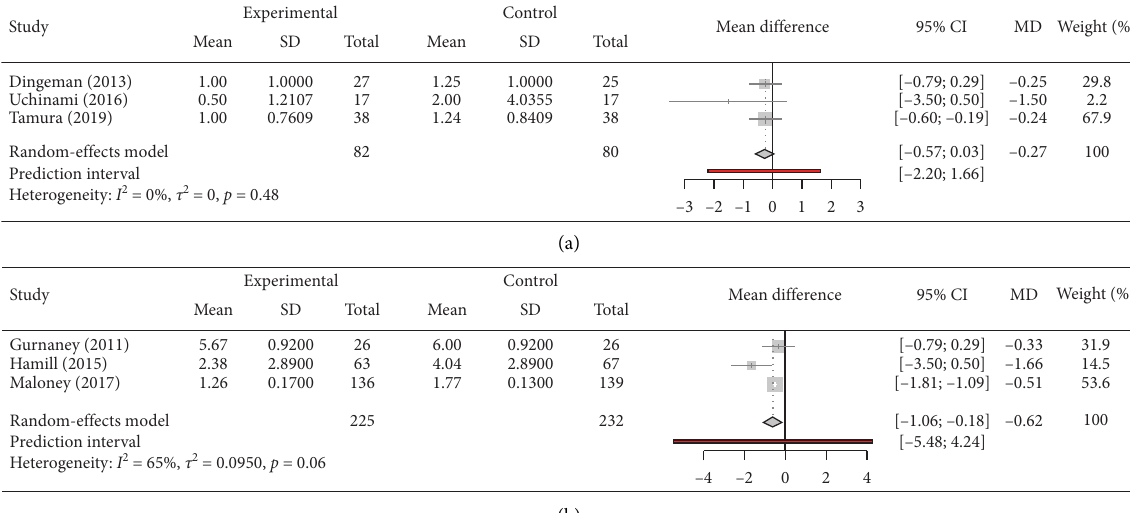
Figure 4: Pain score of (a) RPV group and (b) BPV group. The square symbol on forest plot denotes the weighted mean difference for individual studies, with 95% CI of the difference represented as a solid line. The size of square and thickness of the 95% CI line resemble sample size. RPV: ropivacaine; BPV: